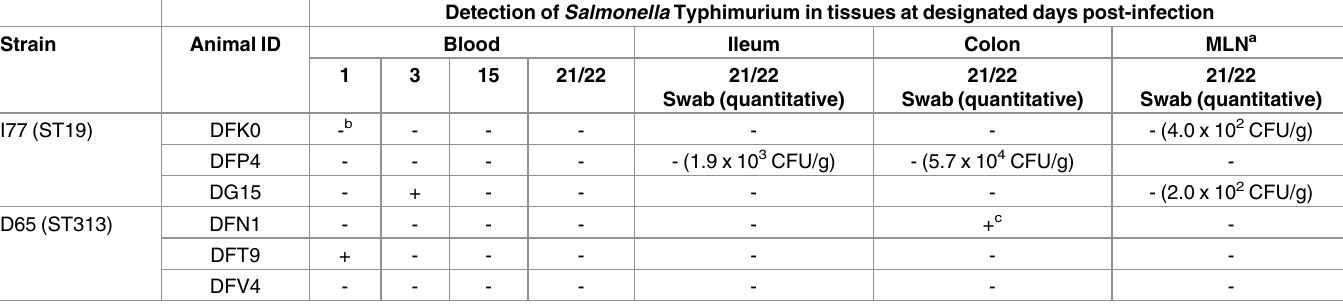
Detection of Salmonella Typhimurium in tissues at designated days post-infection